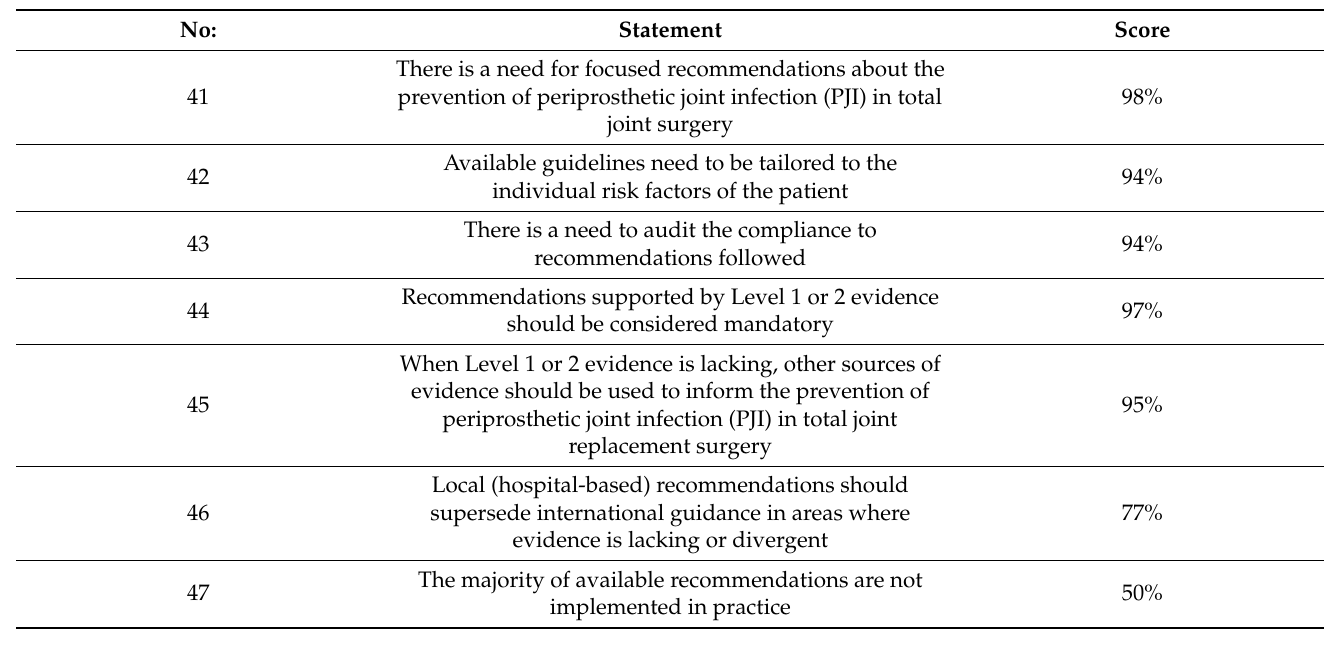
Table 6. Consensus statements and agreement scores on Domain F: role and suitability of the current guidelines.